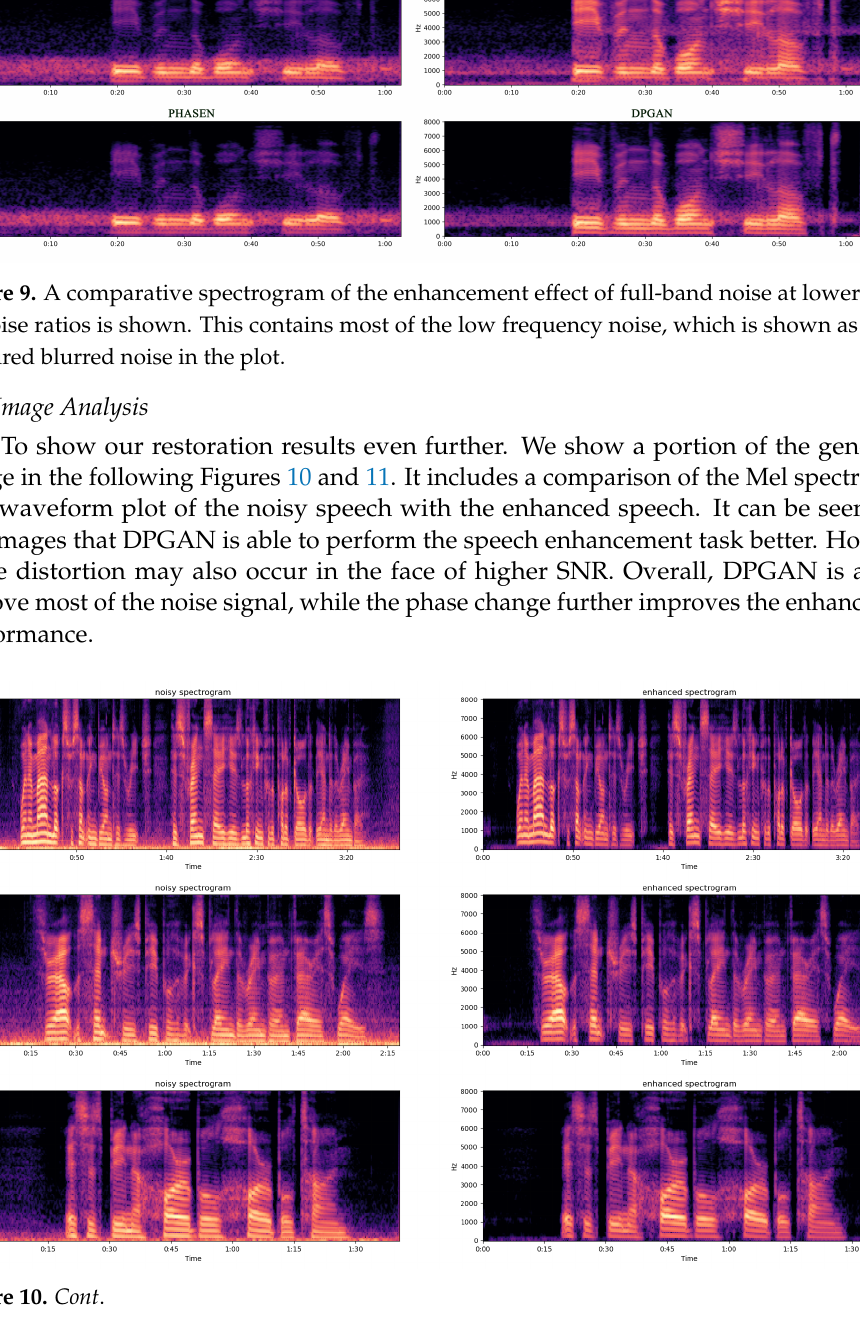
Figure 10. A comparison of the Mel spectrograms of the noisy speech and the enhanced speech, where the left is the noisy speech and the right image is the enhanced speech.